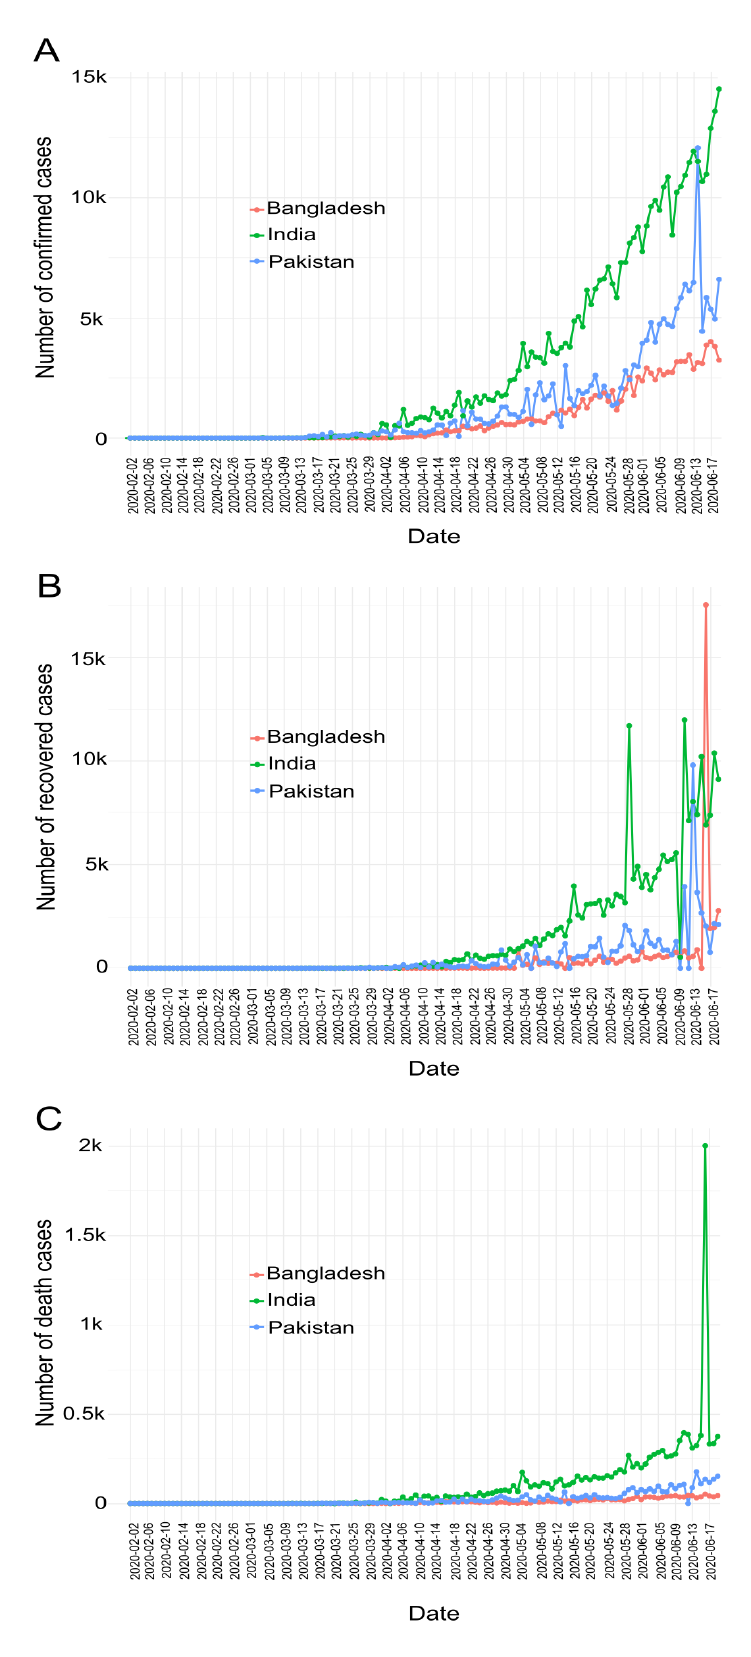
Figure 2. COVID-19 daily cases in Bangladesh, India and Pakistan: ( A ) Confirmed cases ( B ) Recov- ered cases ( C ) Death